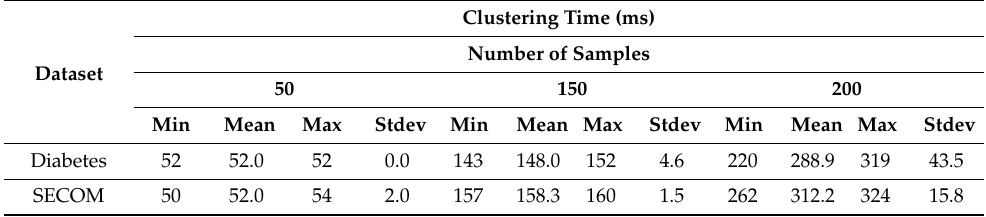
Table 5. k-means clustering time performance on the edge device with confidence algorithm disabled.